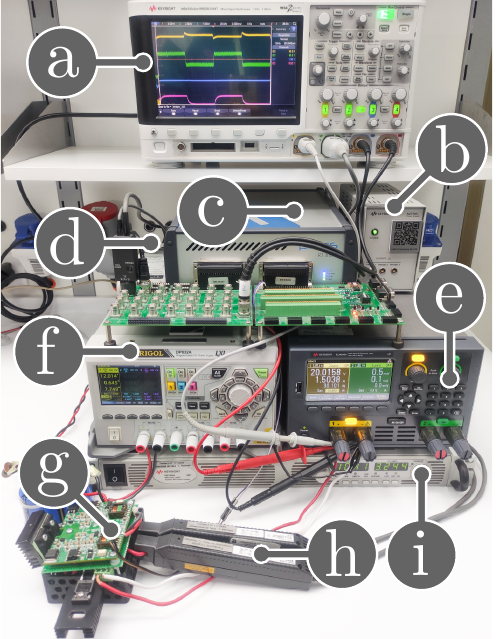
Figure 3. Experimental setup: (a) oscilloscope, (b) DC electronic device in CPL mode, (c) RT-Box with analog and digital breakout boards, (d) current probe power supply, (e) MOSFET driver power supply, (f) DC–DC boost converter, (g) current probes, (h) input voltage power supply, and (i)